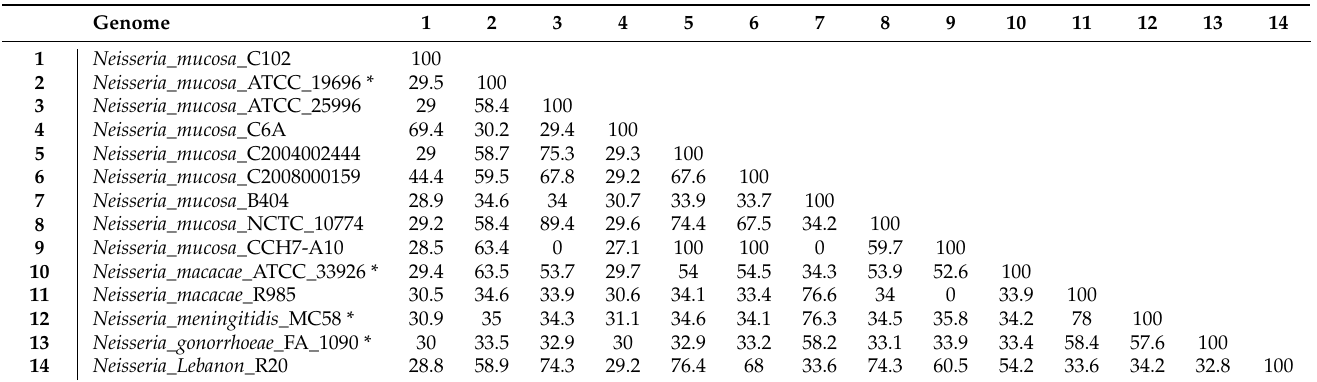
Table 3. Comparison of N. mucosa R20 with related Neisseria spp. using GGDC, formula 2 (DDH estimates based on identities/HSP length).